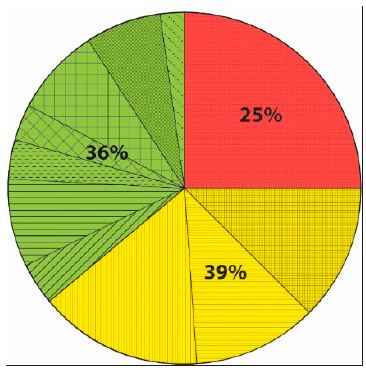
Figure 14. The combinations groups of the cryogenic processes.